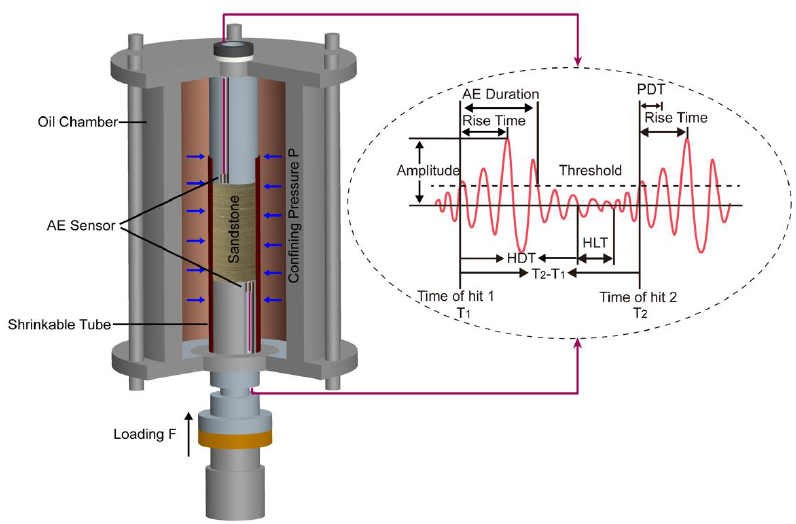
Figure 1. Schematic diagram of the compression arrangement. The confining stresses were provided by the oil pressure. Acoustic emission sensors were embedded in the vertical compression plates. Acoustic emission (AE) hit feature extraction diagram.